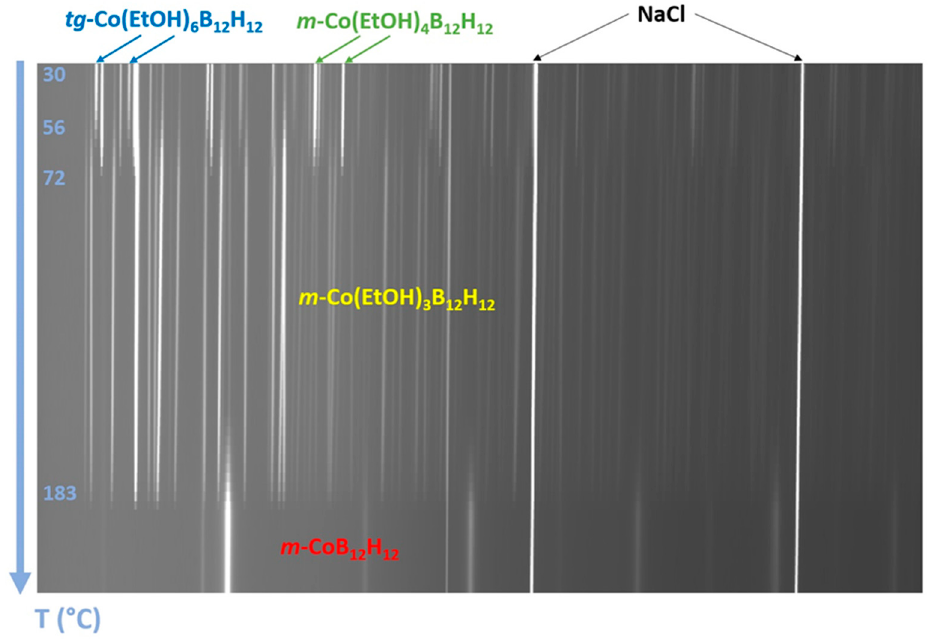
Figure 3. Temperature dependent X-ray powder diffraction patterns (T-ramp) for ball-milled Na 2 B 12 H 12 + CoCl 2 mixture loaded with ethanol (heating rate 6 K/min under dynamic vacuum, λ = 0.69425 Å).